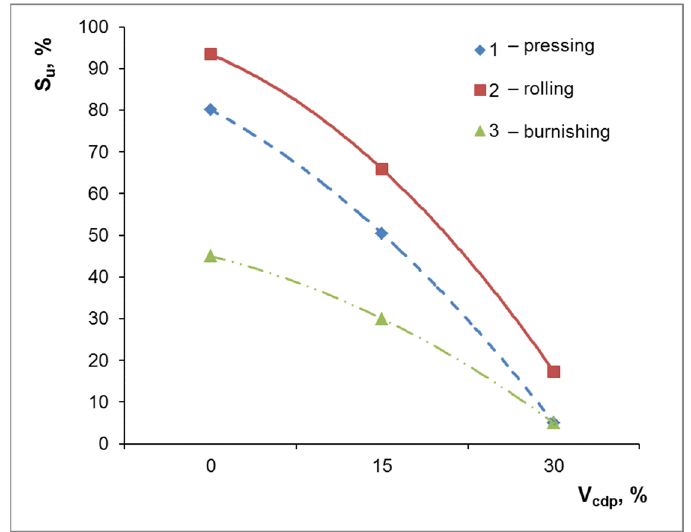
Figure 8. The influence of volume fraction ceramic dispersed phase V cdp in achieved composite coatings on relative strengthening ratio after plastic working, 1—pressing, 2—rolling,